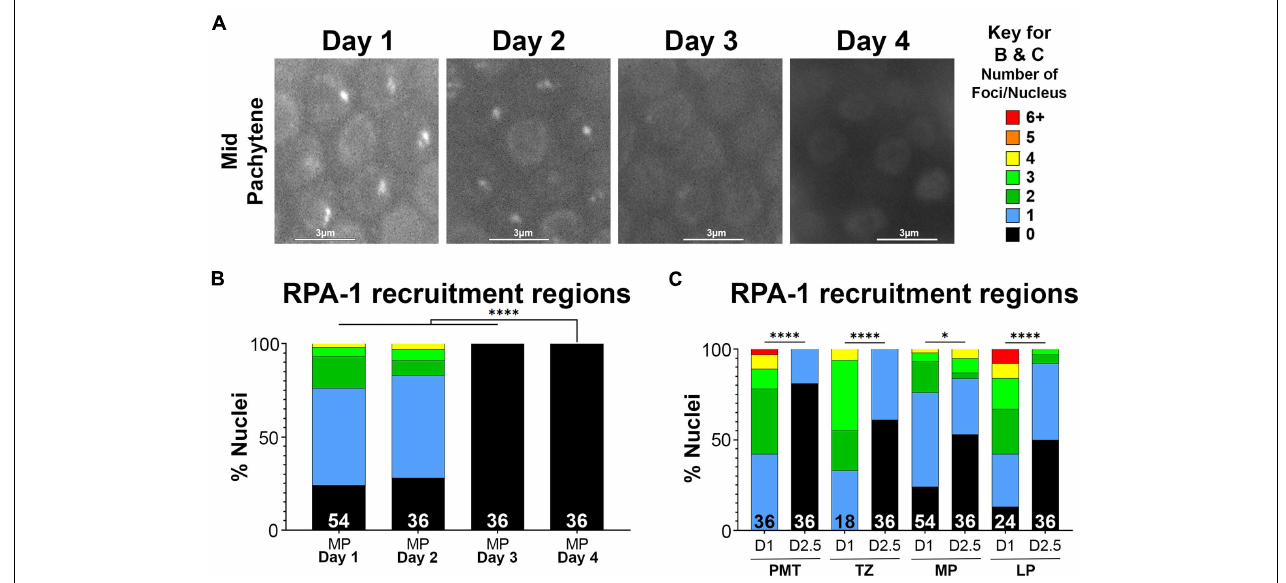
FIGURE 4 | Recruitment of RPA-1 to complex DNA damage decreases with maternal age upon DSB formation. Live imaging of mid-pachytene nuclei post-exposure to microirradiation. (A) Left: Representative images from each age of worms examined showing GFP::RPA-1 fluorescence in 20 min post- microirradiation. Images are extracted from the 45-min live-imaging sequence. Scale bars are 3 µ m. Right: Key for number of recruitment regions represented by each color in panels (B,C) . (B) Percent of mid-pachytene (MP) nuclei for each age of worm (days post-L4) with the indicated number of GFP::RPA-1 recruitment regions. (C) Percent of nuclei in 1-day- and 2.5-day-old adults with the indicated number of GFP::RPA-1 recruitment regions (PMT, pre-meiotic tip; TZ, transition zone; MP, mid-pachytene; LP, late pachytene). Statistical significance was determined using the Fisher’s Exact test and p -values are indicated as follows: ns ≥ 0.1234, 0.0332–0.1233 = ∗ , ≤ 0.0001 = ∗∗∗∗ . Nuclei n -values as indicated for each